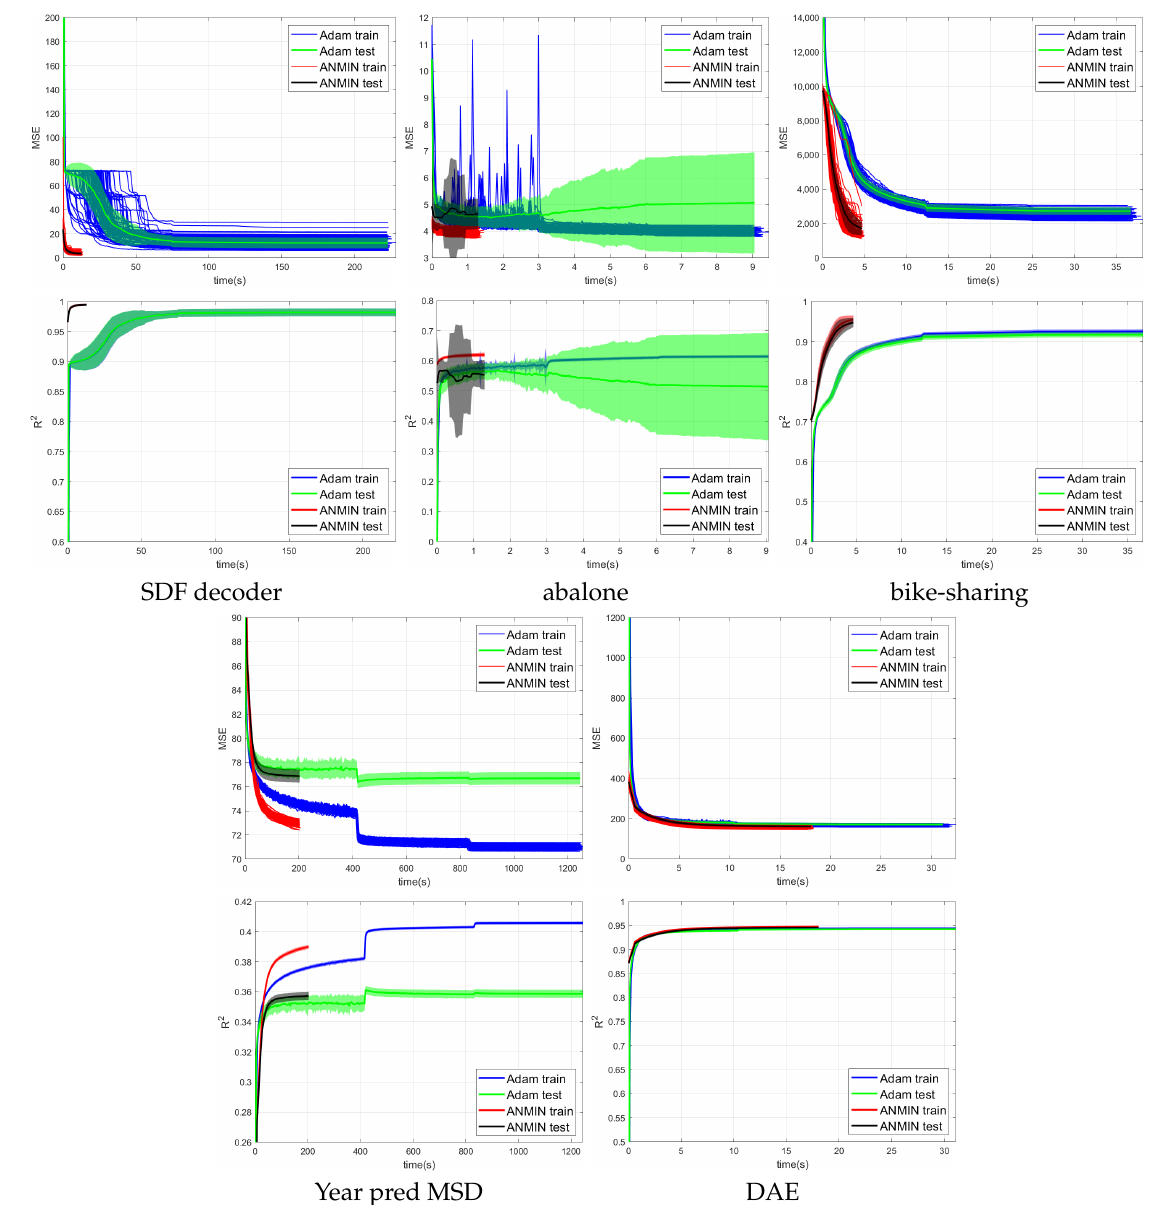
Figure 4. MSE and average R 2 vs. time (seconds) of 100 runs of training the NN with ReLU activation using the Adam, and ANMIN optimizers. Additionally plotted are the mean test MSEs and R 2 with standard